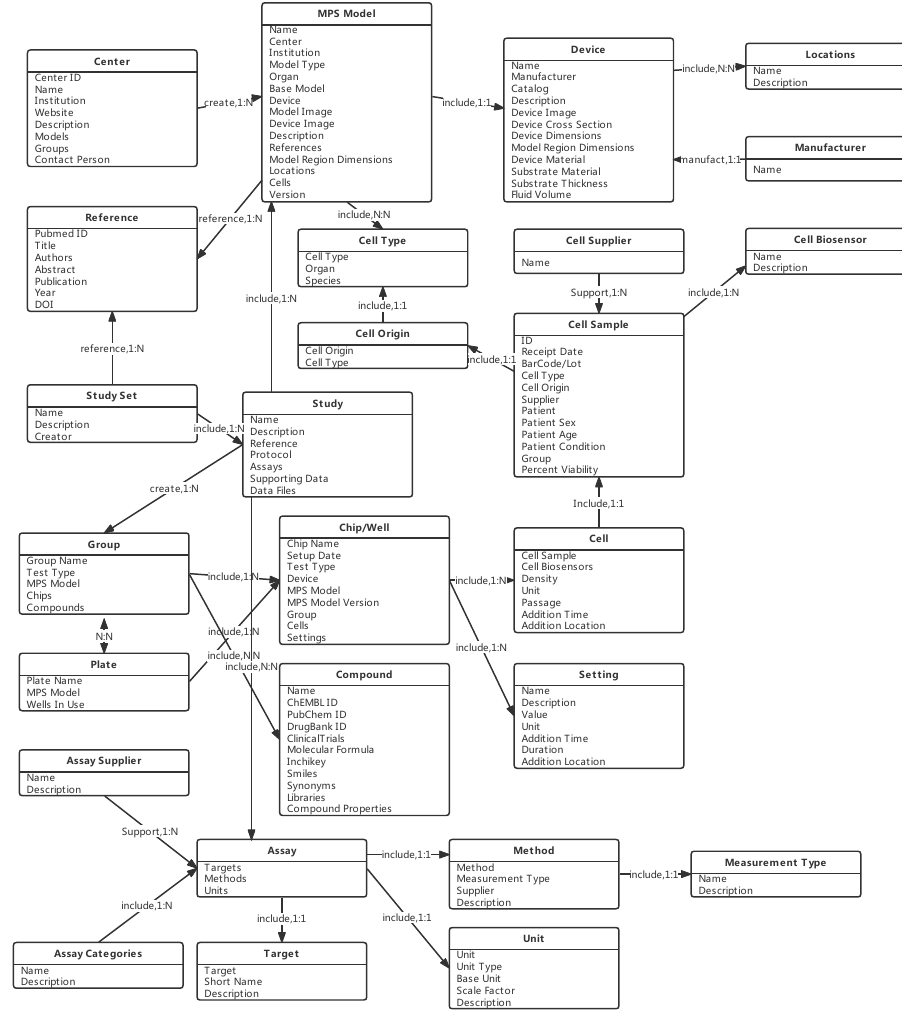
Figure 5. Entity relationship diagram abstracted from BAP website and OOC structure and clas- sification. The rectangles in the figure represent entities, i.e., data objects in the data model. Each entity consists of its name and a set of attributes. The arrows between the entities represent the relationships between them, which are labeled with the type of relationship as well as the number. For example, devices are included in the MPS models, and each device entity forms dependencies with only one MPS model entity. The set of entities marked with different colors can be divided into different modules of the